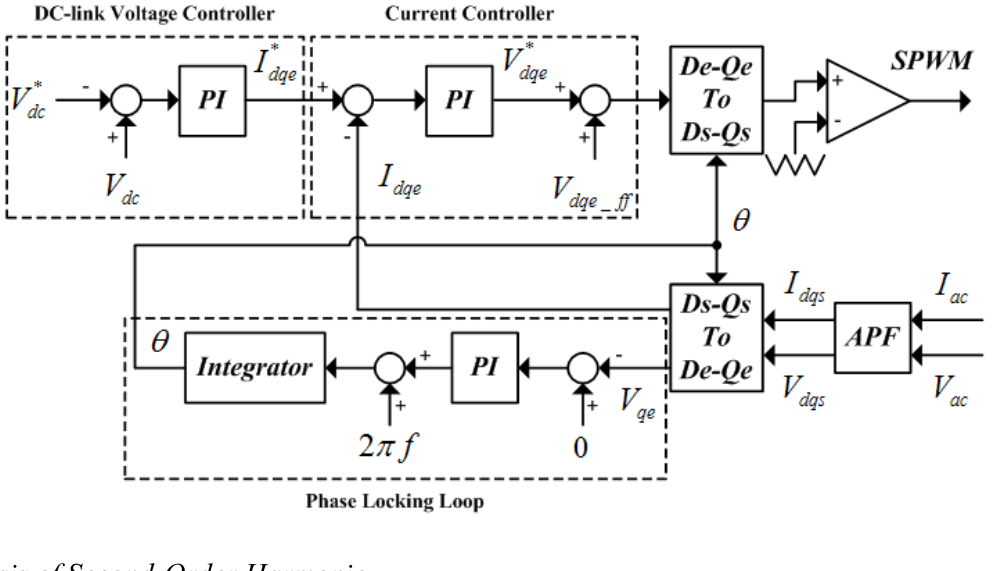
Figure 5. Block diagram of DC/AC inverter control for single-phase